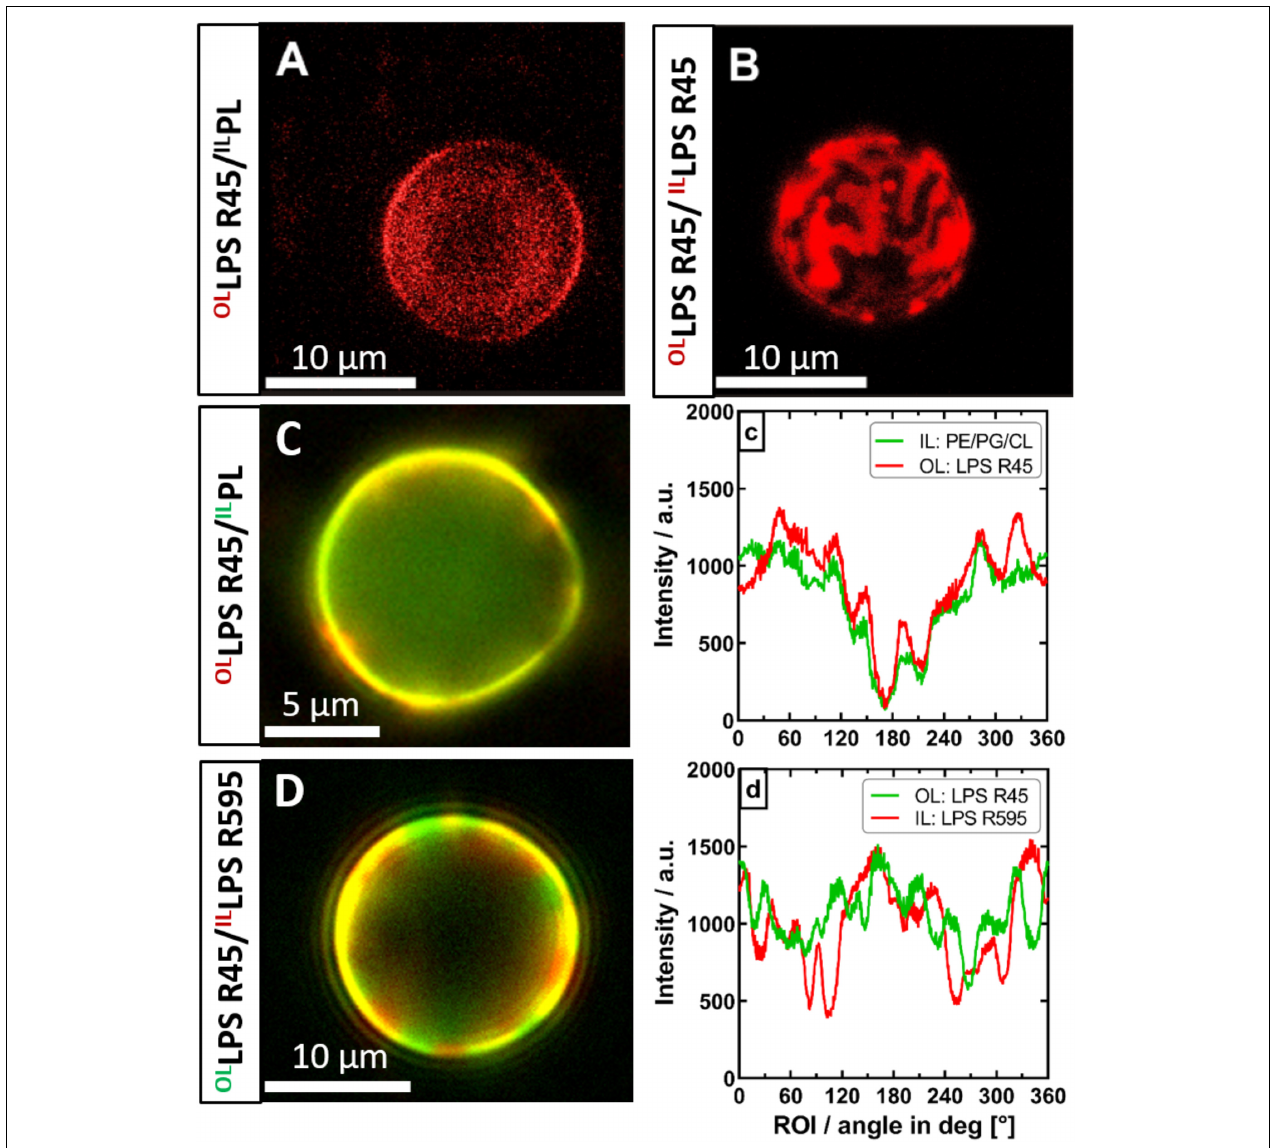
FIGURE 6 | The phase separation of the outer leaflet of asymmetric vesicles is depending on interactions with the inner leaflet. Both asymmetric and symmetric giant unilamellar vesicles were generated by the phase transfer method. (A) Asymmetric LPS R45/ Rho PL vesicles expose no phase separation (PL refers to PE:PG:CL; 81:17:2; w/w/w). (B) Symmetric Rho LPS R45/ Rho LPS R45 vesicles show dominant phase separation in the outer as well as in the inner leaflet (IL), exposing stripe and patch shaped domains. (C) Phase separation in asymmetric LPS R45/PL vesicles could not be enforced by lowering divalent cation content. (c) Fluorescence dye distribution analysis of IL and outer leaflet (OL). The fluorescent dye conjugates of both leaflets correlate and show an intensity minimum at approx. 180 ◦ . (D) Asymmetric FITC LPS R45/ Rho LPS R595 vesicles show a dominant phase separation with areas wherein the fatty acid chains of the different LPS types match (yellow) and mismatch (red/green). (d) Fluorescence dye distribution analysis of the individual LPS leaflets giving areas of correlation and anti-correlation of the different fluorescence labels. All experiments were run out in 100 mM KCl buffer supplemented with either 5 mM MgCl 2 and 5 mM HEPES (A+B,D) or 0.5 mM CaCl 2 x2H 2 O (C) at pH 7. Confocal laser scanning microscopy (A+B) was performed at 26 ◦ C. Images were taken with a Leica SP3. Z-series were performed and compiled for 3D visualization. Inverse fluorescence microscopy was performed at room temperature with an Olympus IX-81.